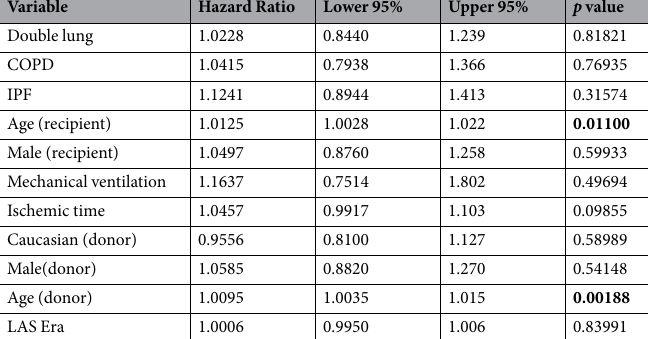
Table 3. Cox regression model in non-white subjects who undergone lung transplant for COPD, IPF and sarcoidosis in the US in from December 2005 through December 2015.